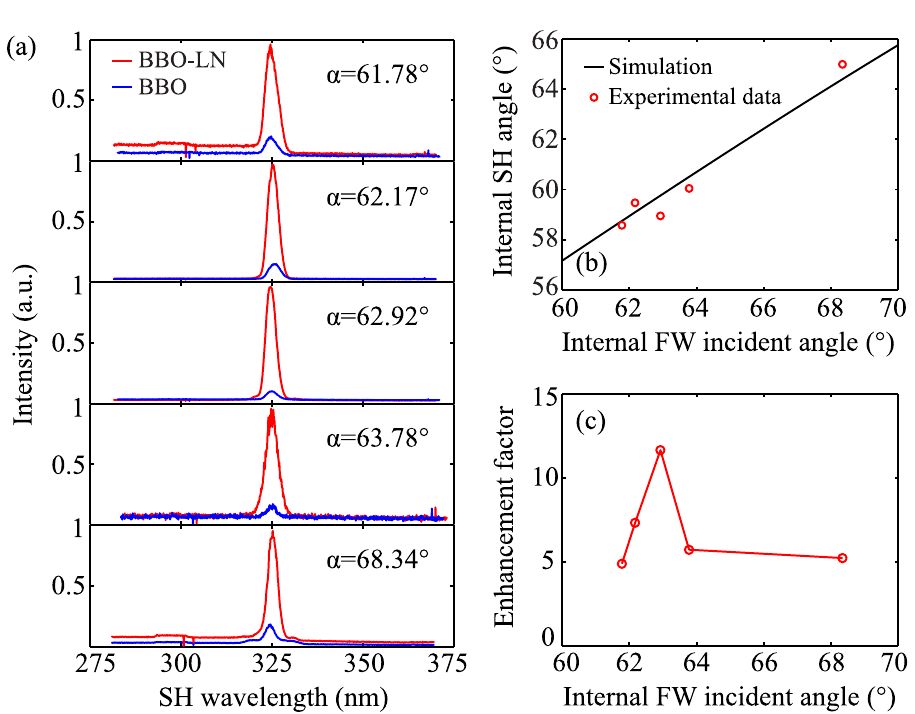
Figure 4. ( a ) Spectrum of SH generated on BBO boundary (blue) and interface of BBO-LN (red) with a set of FW incident angles. ( b ) Internal radiation angle of SH θ versus internal FW incident angle α . Theoretical prediction (solid curve) and experimental results (symbols) are in good agreement. ( c ) Measured enhancement factor of SH generated at the BBO-LN interface and boundary of BBO